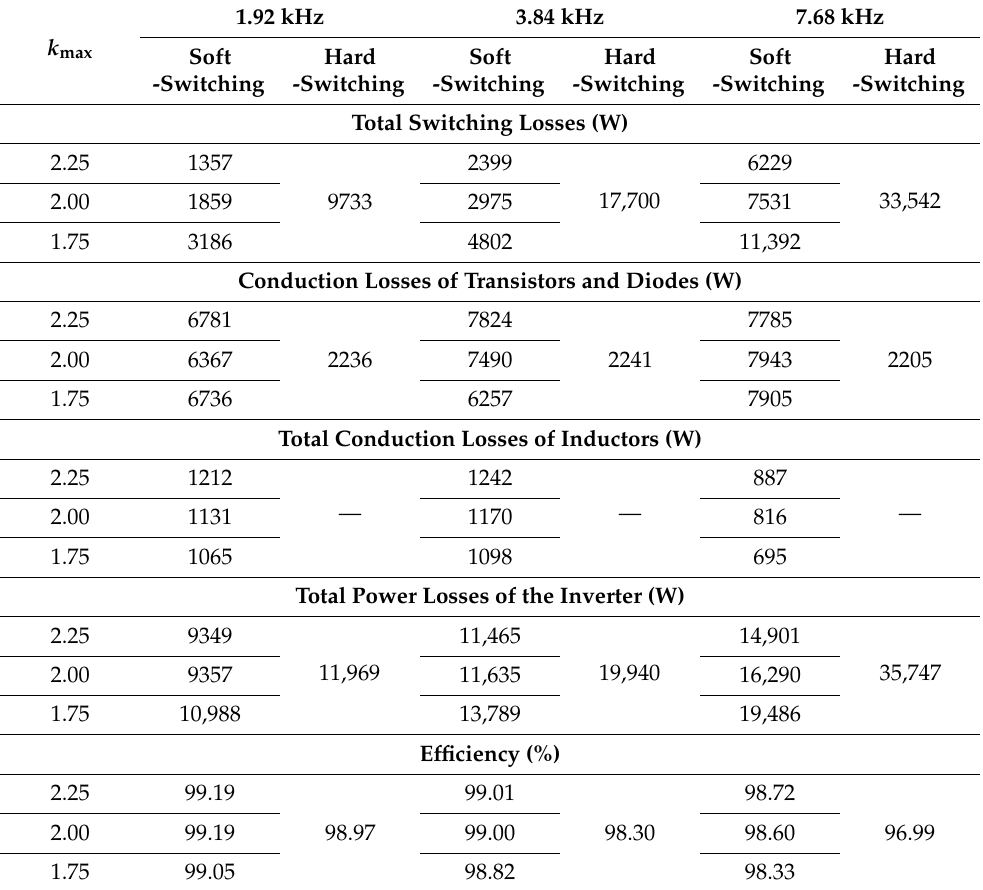
Table 4. Comparison of power